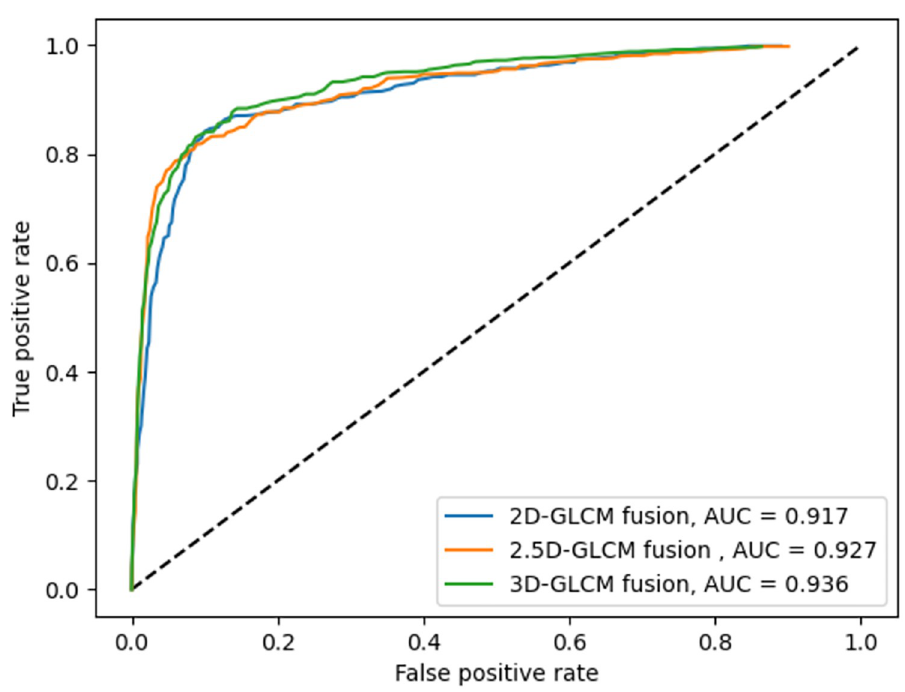
Fig 7. ROC curves for three fusion models and their corresponding macro-averaged AUC